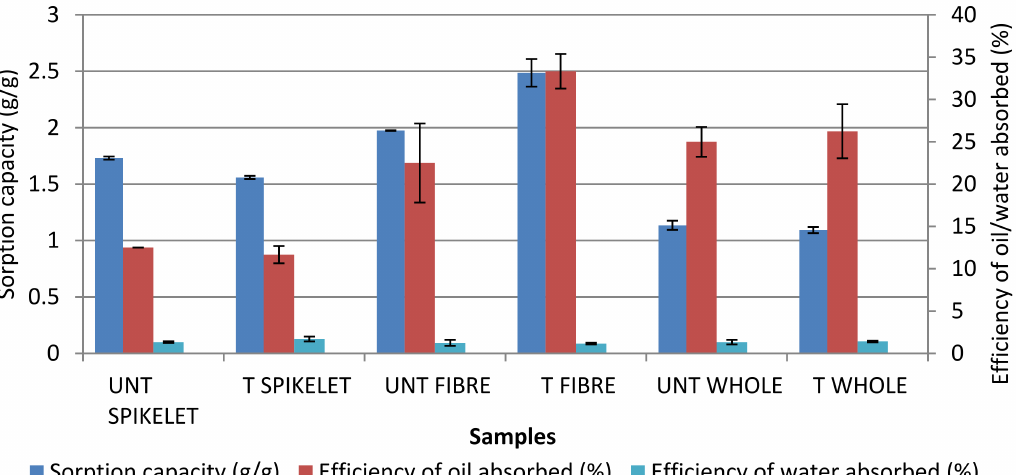
Figure 1. Screening part of EFB samples and efficiency of oil and water absorbed. UNT: Untreated; T: